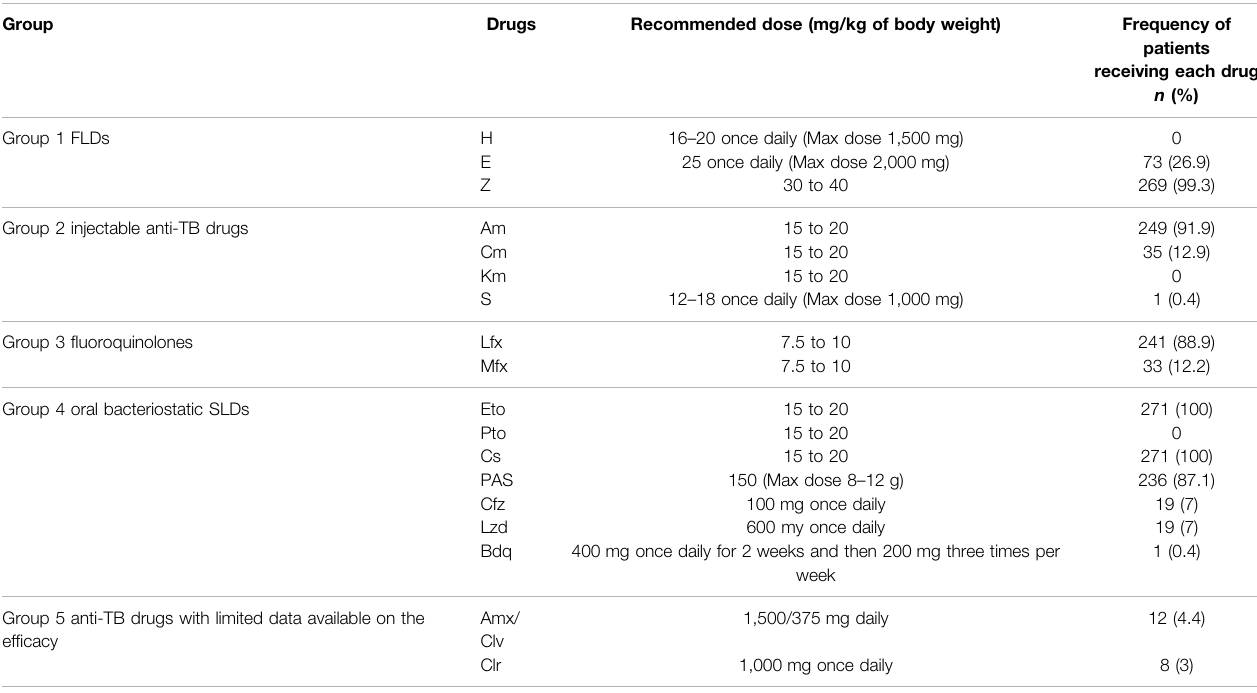
TABLE 4 | Drugs used along with daily dose and frequency of patients receiving each drug.